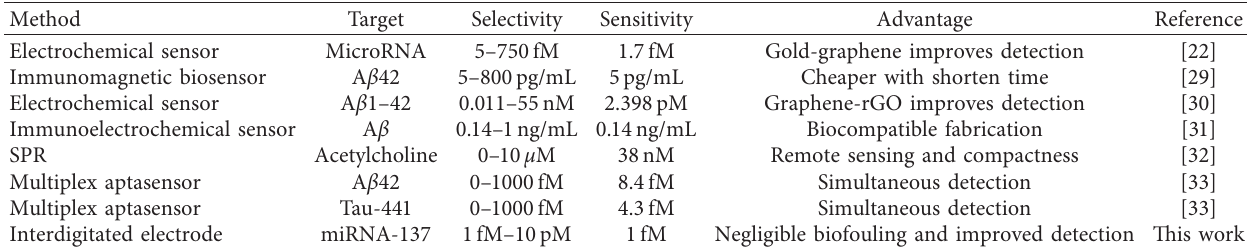
Table 1: Comparison among the available methods for Alzheimer’s disease identification.